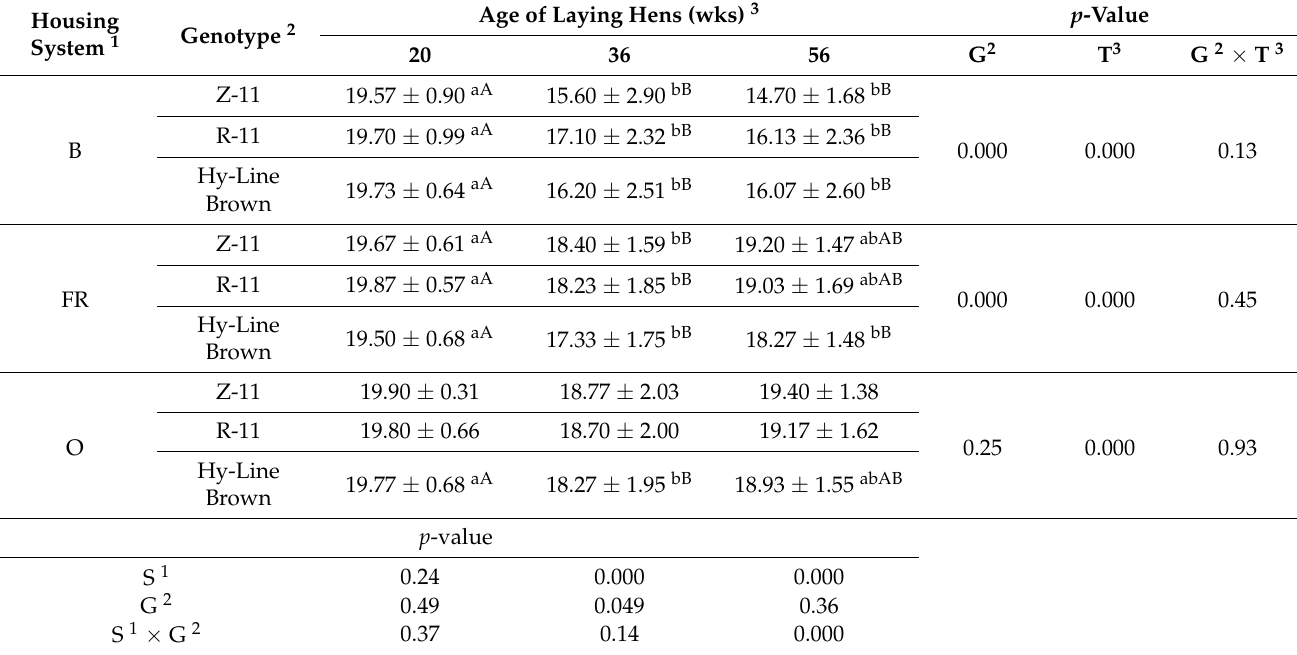
Table 2. Total plumage (sum of head, neck, back, abdomen, and tail plumage) of laying hens from different types of alternative housing